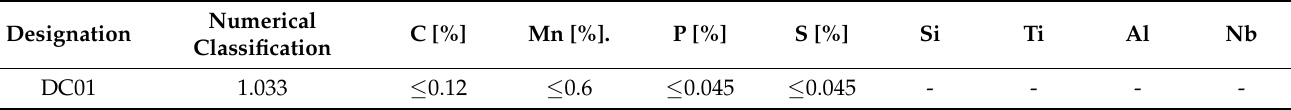
Table 1. Chemical composition (%).